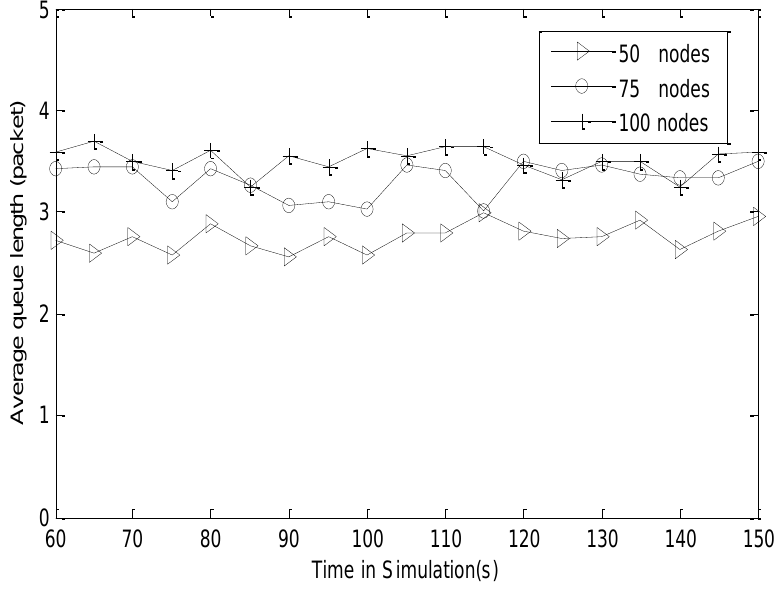
Figure 12. The average queue length of node in the